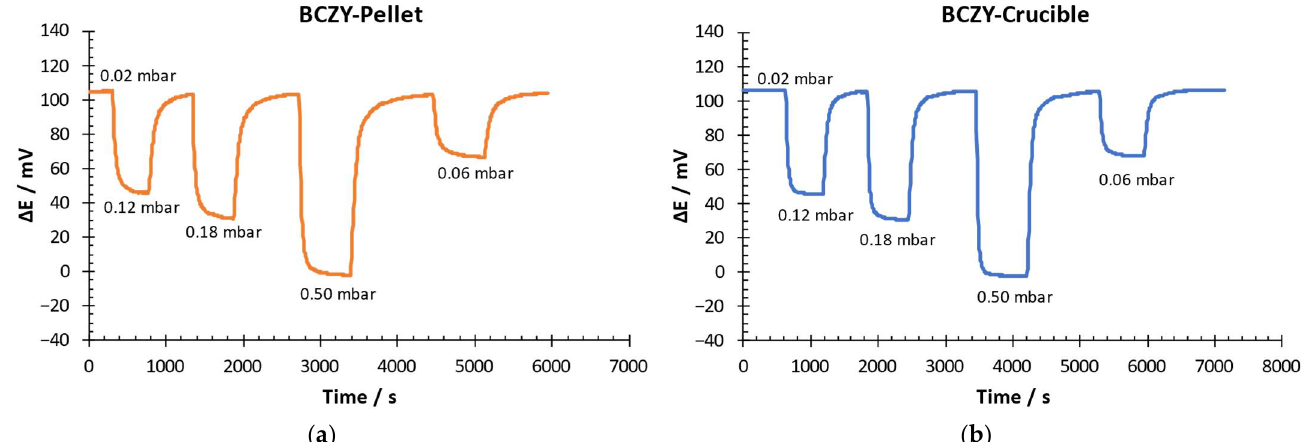
Figure 8. Dynamic response–recovery curve of ( a ) BCZY-Pellet and ( b ) BCZY-Crucible.